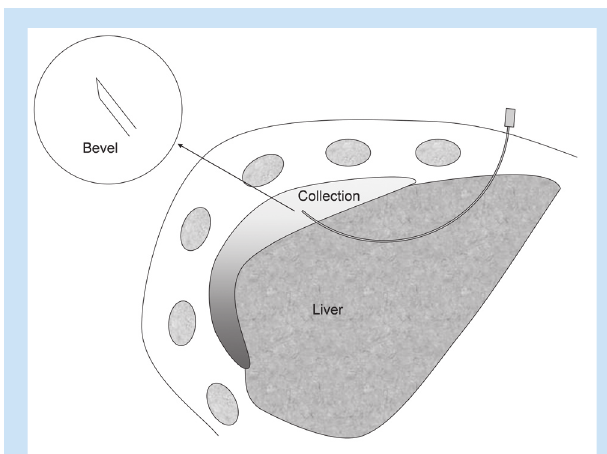
Fig. 3. Diagram of curved fine-needle path; needle bevel position as shown in